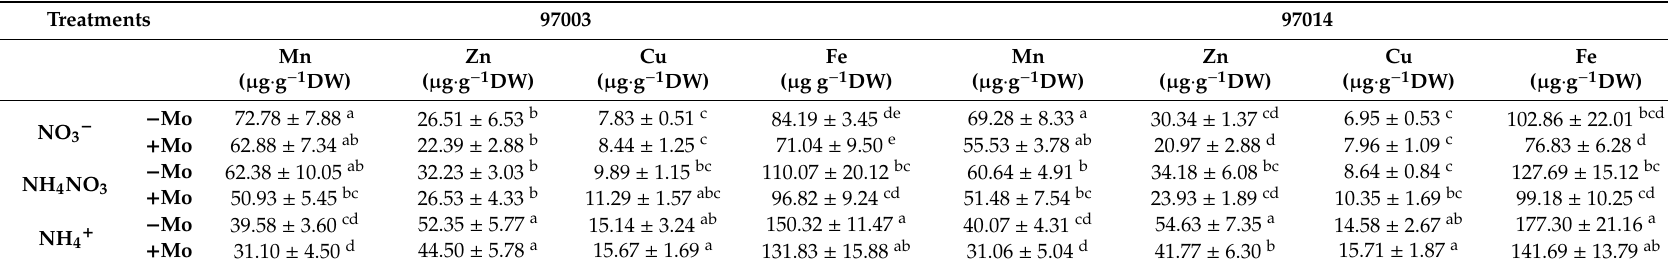
Table 3. Influence of Molybdenum (Mo) supply on manganese, zinc, copper, and iron concentrations in leaves of Mo-e ffi cient ‘97003’ and Mo-ine ffi cient ‘97014’ winter wheat cultivars under di ff erent N